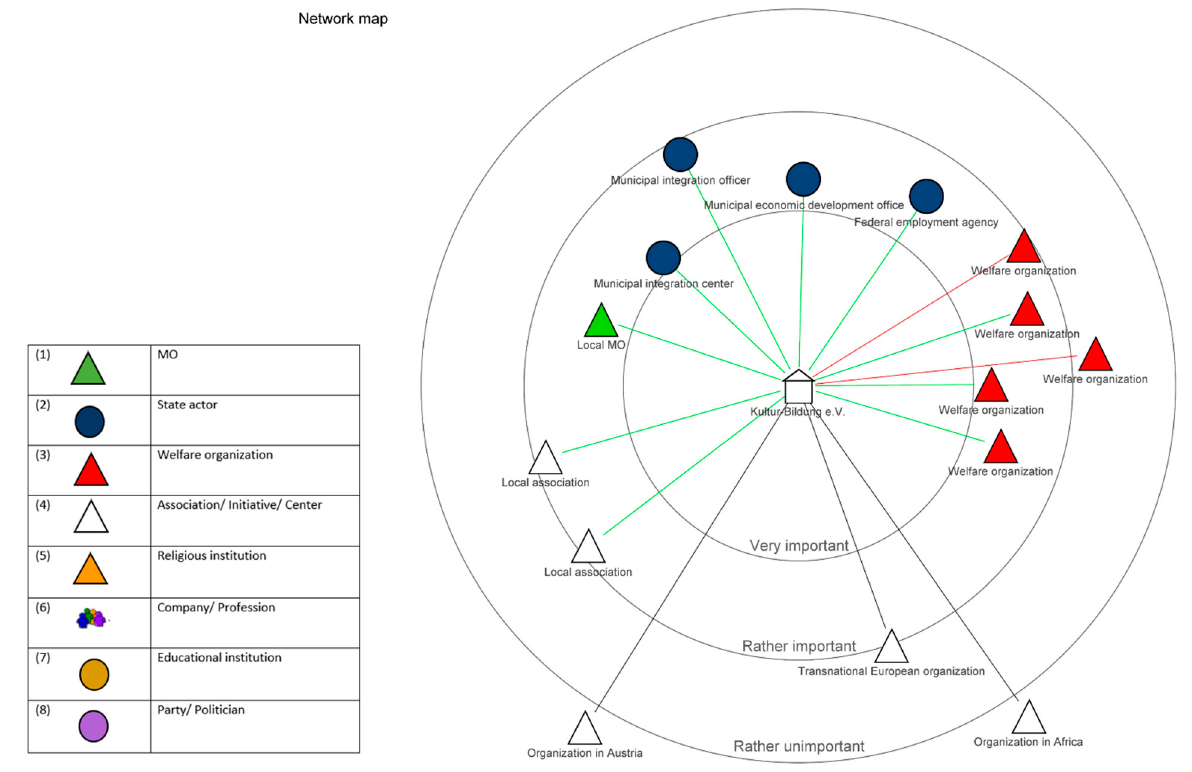
Figure 4. Network map of Kultur-Bildung e.V.